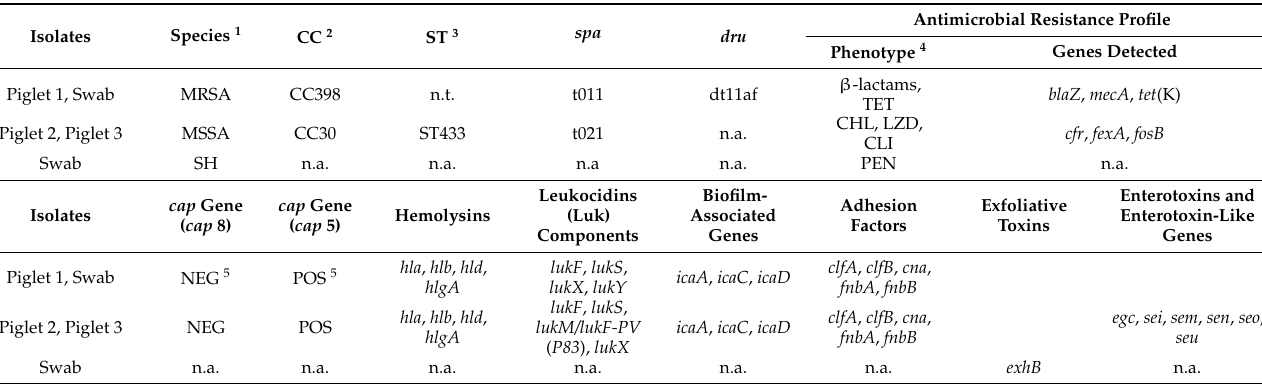
Legend Table 1: 1 S = Species, MRSA = methicillin-resistant Staphylococcus aureus ; MSSA = methicillin-susceptible Staphylococcus aureus ; SH = Staphylococcus hyicus ; 2 clonal complex; 3 sequence type; 4 Phenotype: PEN = penicillin; CHL = chloramphenicol; LZD = linezolid, CLI = clindamycin; TET = tetracycline; 5 NEG = negative, POS = positive, n.t. = not typable, n.a. = not assessed; AMR = antimicrobial